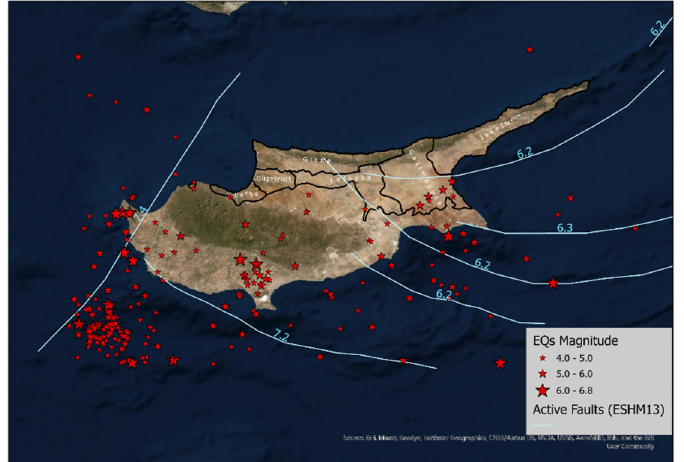
Figure 3. Active faults from ESHM13 with maximum possible magnitudes and earthquake distribution in Northern Cyprus since 1956.